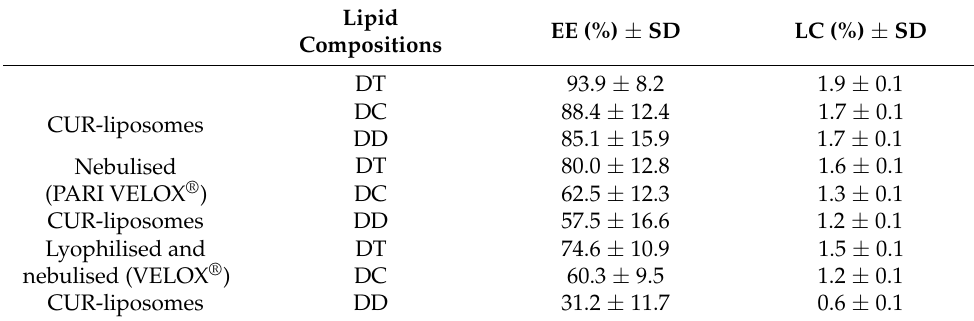
Encapsulation efficiency (EE) and loading capacity (LC) of DT (DPPC:TEL), DC (DPPC:Chol) and DD (DPPC:DOPE) liposomes. The results in this table were calculated according to Equations (1) and (2) in Section 2.8 for liposomes containing a curcumin concentration of 0.1 mg per 1 mg lipids. Unnebulised curcumin-loaded liposomes were used as